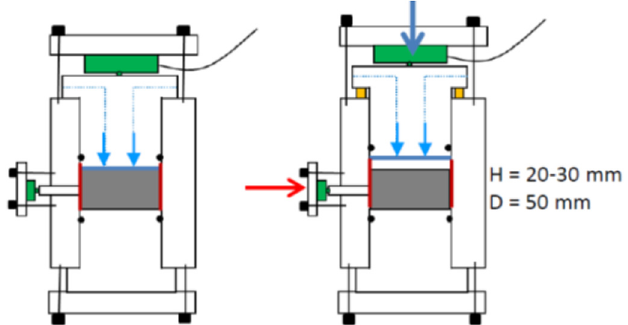
Fig. 7. Schematic of the axial swelling tests. The red lines show the lubricated walls and the blue lines indicate fi lters and water supply. The radial pressure transducer is located 10mm above the bottom of the specimen.